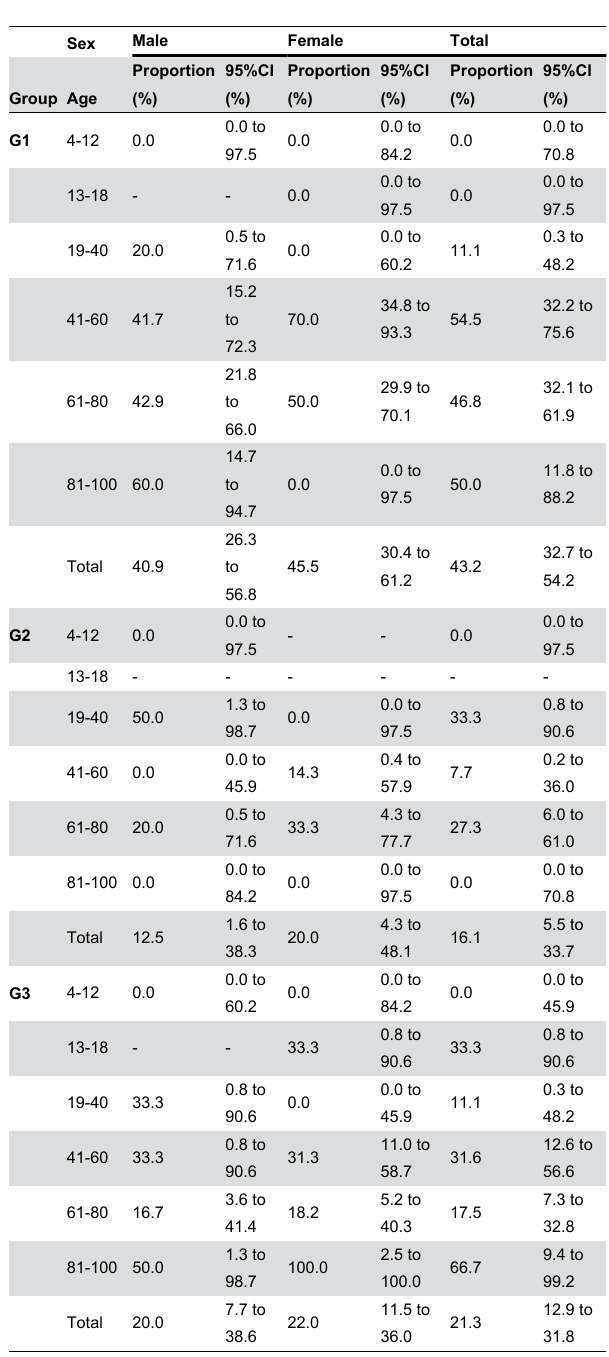
Table 5. Proportions of residents consuming locally grown products by sex, age and population